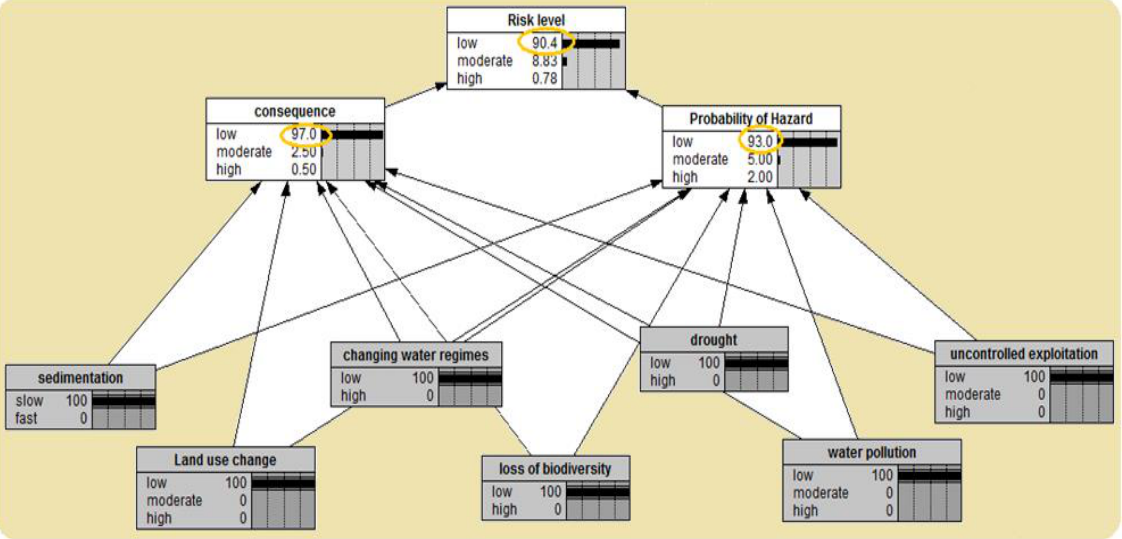
Figure 7. A predictive model for sensitivity analysis of the levels of environmental risk at SIWs.